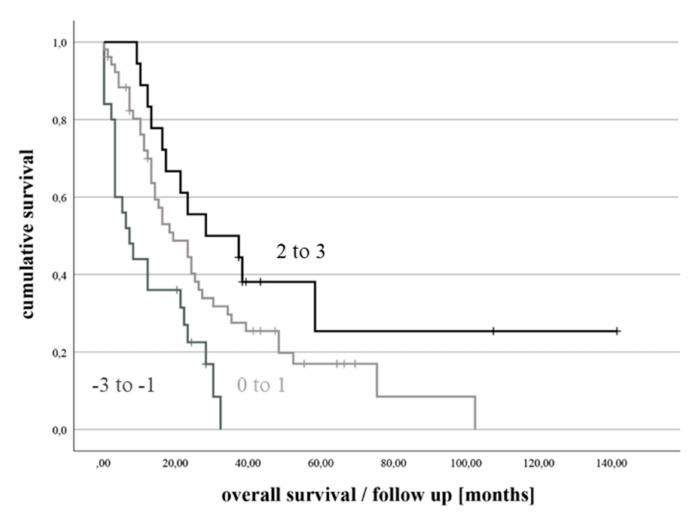
Figure 4. Kaplan-Meier curve for the association between the Total-score and overall survival (log- rank test p = 0.001). According to the Total-score value, the survival curves were divided into three subgroups: “ − 3 to − 1 points”. “0 to 1 point”. “2 to 3